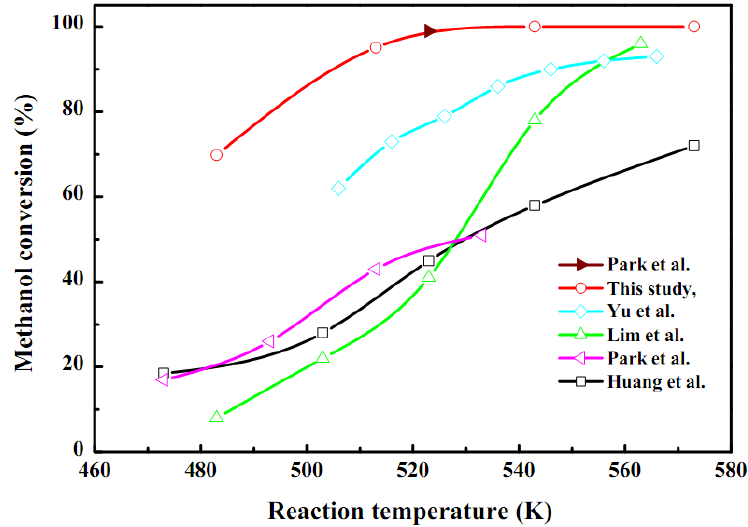
Figure 8. Comparision of methanol conversion of as-synthesized CuO/ZnO-Al sol for autothermal reforming of methanol in a microreactor washcoat with ZrO 2 (steam/MeOH = 1.3; WHSV = 10 h − 1 ; loading weight of washcoat catalyst = 10 mg/plate) and with literature works.